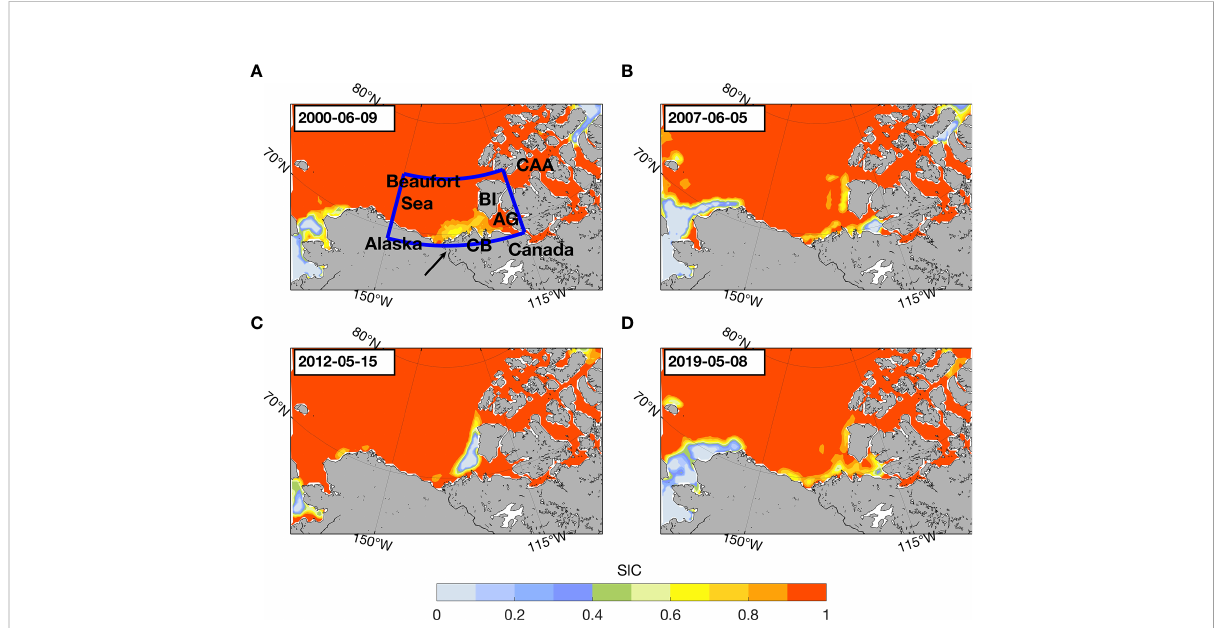
FIGURE 1 Daily mean ice concentration on (A) 9 June, 2000, (B) 5 June 2007, (C) 15 May 2012, and (D) 8 May 2019. The study domain (69 °N – 75 °N and 115 °W – 150 °W ) is indicated by the blue box. The black arrow represents the western edge of the Mackenzie River delta. Additionally, the Canadian Arctic Archipelago (CAA), Banks Island (BI), Amundsen Gulf (AG), and Cape Bathurst (CB) are